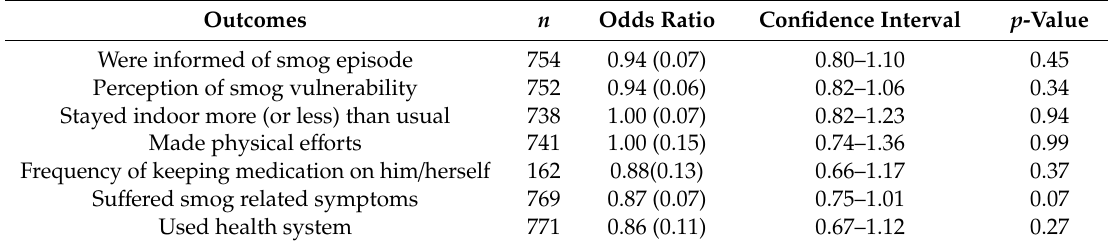
Table 2. Comparison between treatment and control groups before exposure to phone smog warning